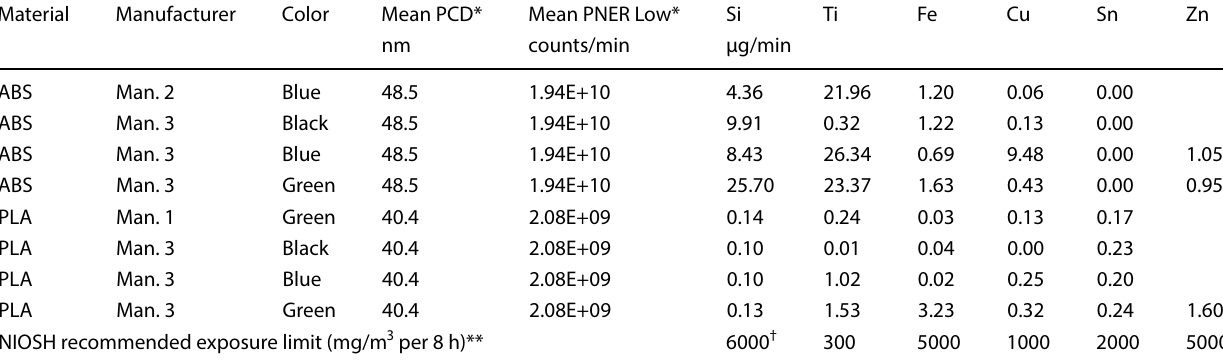
Table 4 Calculated rate of elemental composition and concentration in aerosol emissions produced during 3D printing assuming equiva- lent partitioning from the filament into the